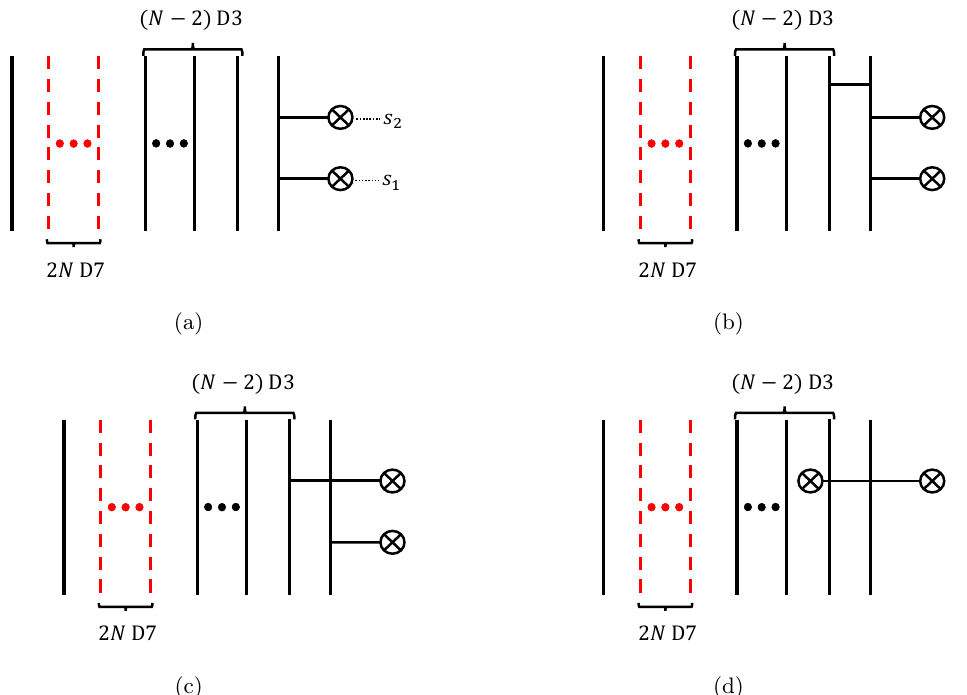
Figure 6 . (a) A brane con(cid:12)guration realizing the ’t Hooft operator with the magnetic charge B = 2 e N . (b) Introducing a smooth monopole with the magnetic charge e N (cid:0) 1 (cid:0) e N by a D1-brane between two D3-branes to (cid:12)gure 6(a). (c) Tuning the position of the D1-brane between D3-branes until it coincides with that for the upper D1-brane between an NS5-brane and the N th D3-brane,